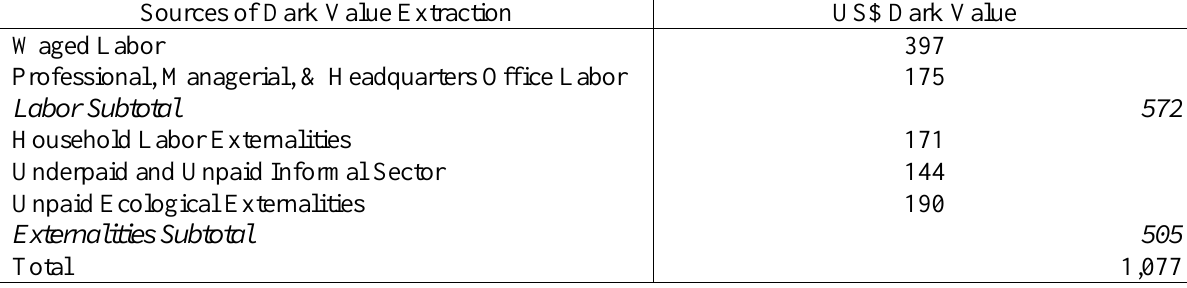
Table 5. Summary of Dark Value Embedded in Each iPad Unit Sources of Dark Value